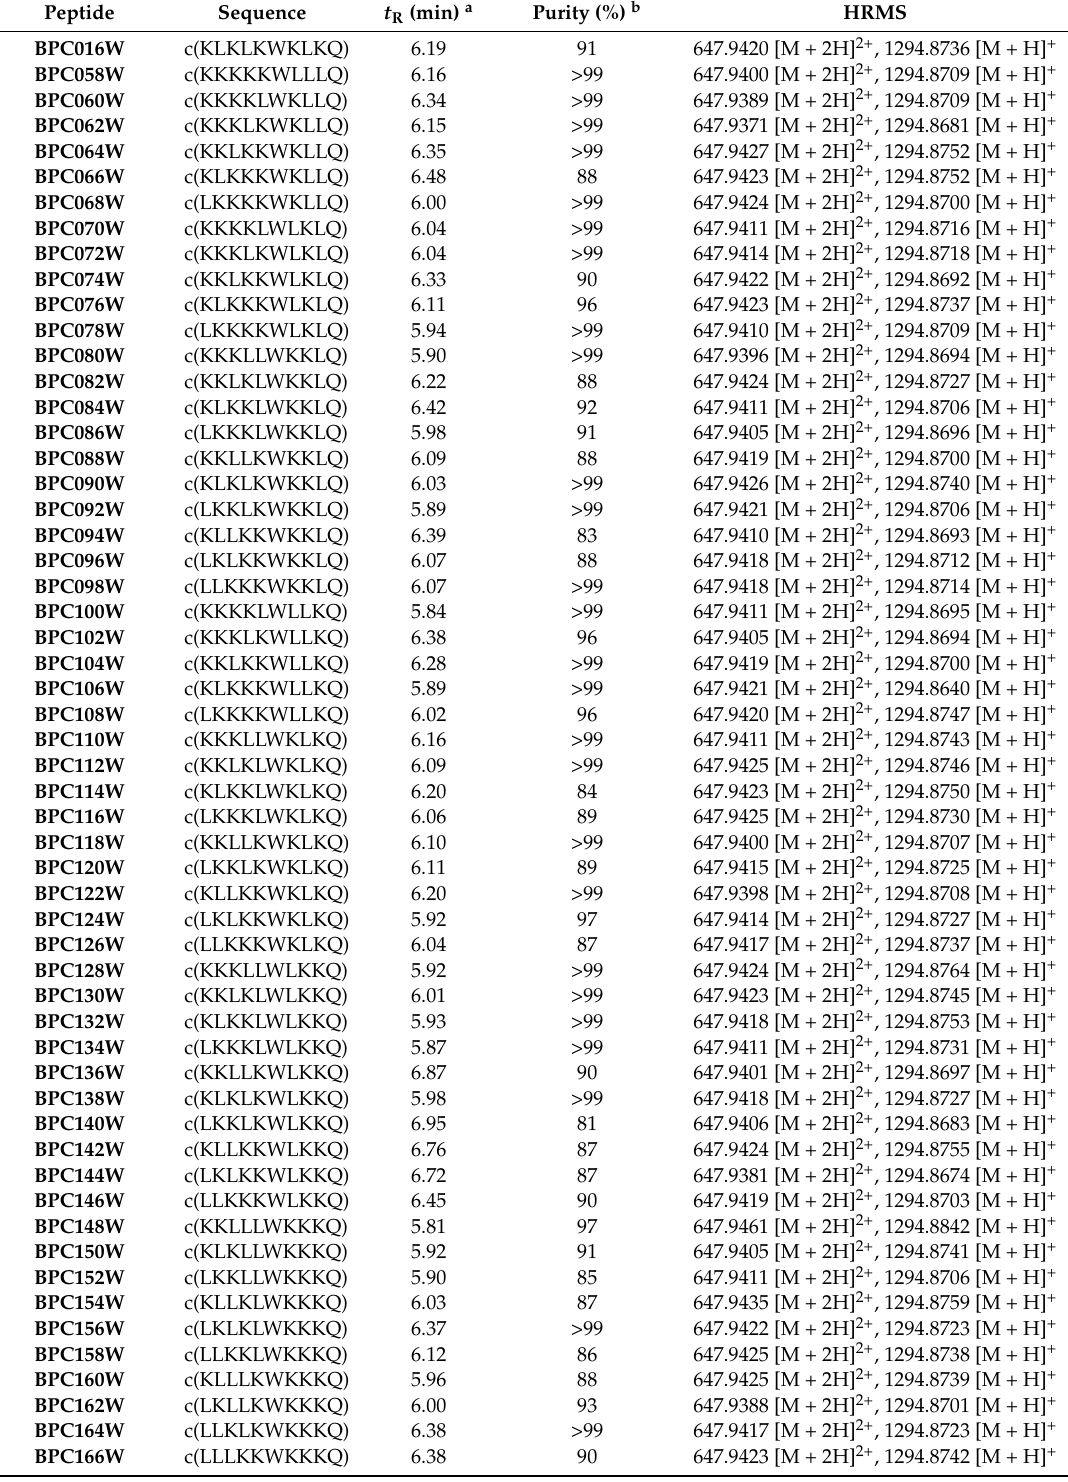
Table 1. Sequences, retention times and purities on high-performance liquid chromatography (HPLC), and mass spectrometry data of cyclic peptides incorporating a